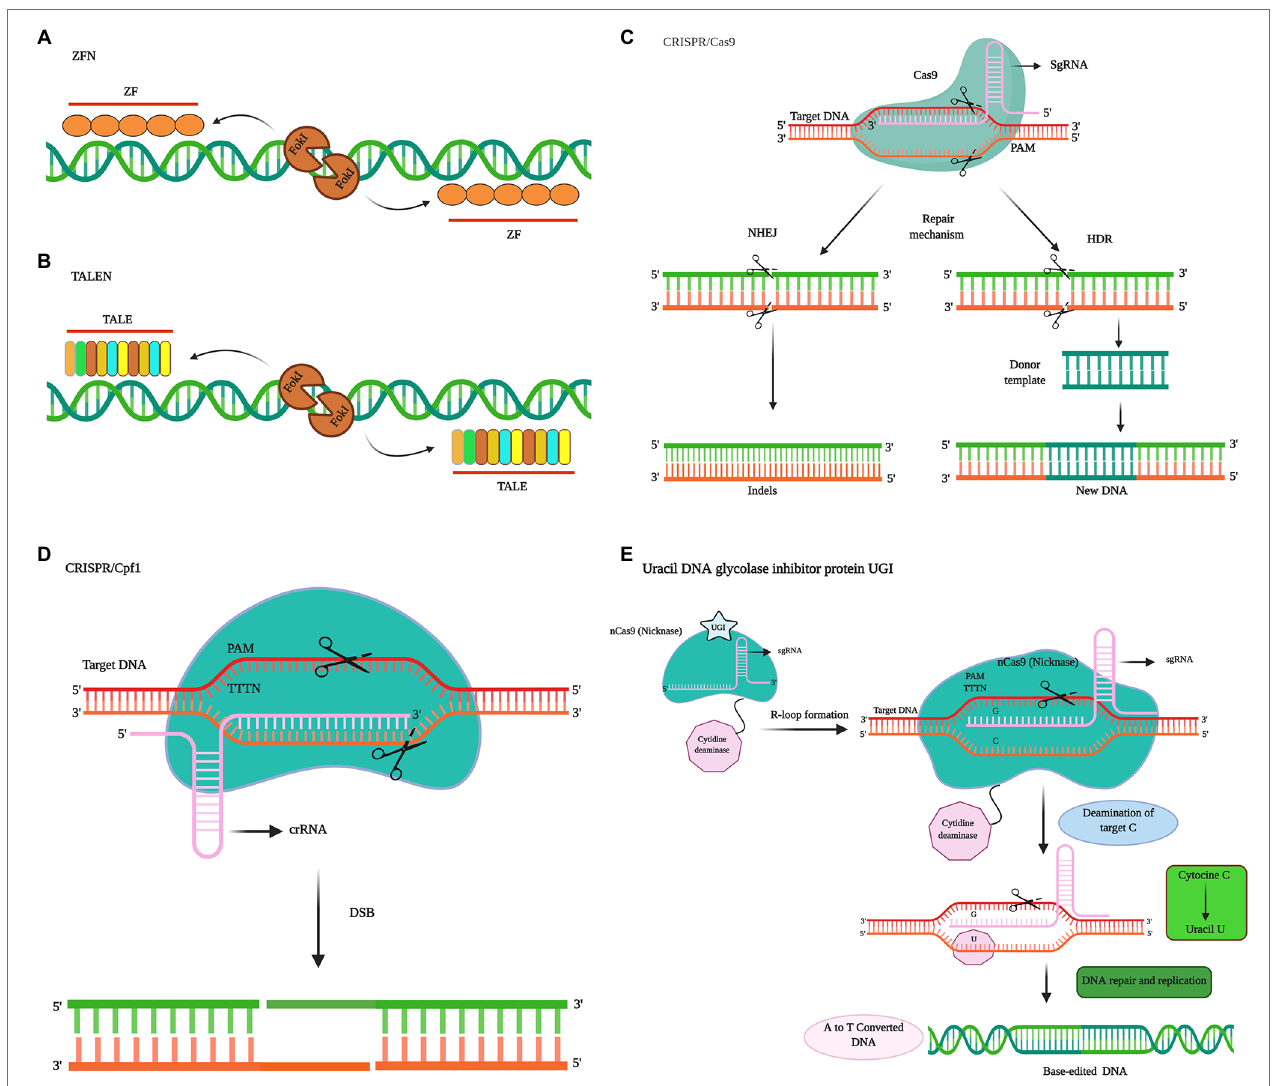
FIGURE 1 | Comparison of different widely used genome editing systems in plants. Site-specific techniques, such as those based on zinc finger nucleases (ZFNs; A ) and protein-dependent DNA cleavage systems, such as those based on transcription activator-like effector nucleases (TALENs; B ). The two sequence-specific zinc finger proteins flank the target sequence, and FokI nuclease follows the C terminus of each protein. Zinc finger proteins are used to direct FokI dimers to target the specific DNA sites to be cleaved. TALENs consist of two sequence-specific TALEN proteins arranged on the target sequence, with FokI nuclease followed by the C terminus of each protein. The TALEN protein directs FokI dimers to the target specific DNA sites to be cleaved. (C) Illustration of a cluster of the regularly spaced short palindrome repeats (CRISPR)/CRISPR-associated nuclease 9 (Cas9) system. CRISPR-Cas induces double-strand breaks (DSB) in the DNA strand. CRISPR RNA (crRNA) directs the Cas9 protein. Trans-activating CRISPR RNA (tracrRNA) is used to stabilize the structure and activate Cas9 to cut the target DNA. Single guide RNA [sgRNA (Gulabi)] recognizes the target gene, and then the Cas9 protein (green) cuts the two strands of the target DNA at the RuvC and His Asn-His (HNH) domains. The cutting of DNA by Cas9 is dependent on the presence of spacer adjacent motif (PAM) sequences. A 20-base sgRNA defines the binding specificity. In DNA, there are two mechanism of double-strand break (DSB) repair, namely, homology-directed repair (HDR), which is activated in the presence of a template and leads to knock-in or gene replacement, and non-homologous end joining (NHEJ), which is not sufficiently precise and leads to permanent gene knockout. (D) The Cpf1 system. Cpf1 is a two-component RNA programmable DNA nuclease related to CRISPR. The PAM of Cpf1 is TTTN. Cpf1 cuts the target DNA and introduces a DSB, a 5-nt staggered cut at the 5 ′ end of the T-rich PAM. CRISPR-Cas9 nickase introduces breaks only in the strand complementary to sgRNA. The double nickase with two sgRNAs introduces a staggered DSB into the DNA, after which HDR repairs the DSB. Uracil DNA glycosylase inhibitor (UGI) protein prevents removal of uracil from the DNA and subsequent repair pathways and contributes to increasing the frequency of